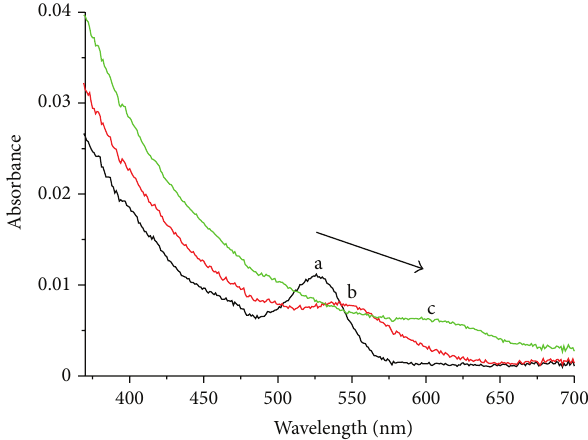
Figure 5: UV-visible absorption spectra of 30 𝜇 M NAC-capped CdTe QDs (2.93 nm) in the presence of various concentrations of Hg(II) ions: (a) 0.0, (b) 1.0, and (c) 2.0 𝜇